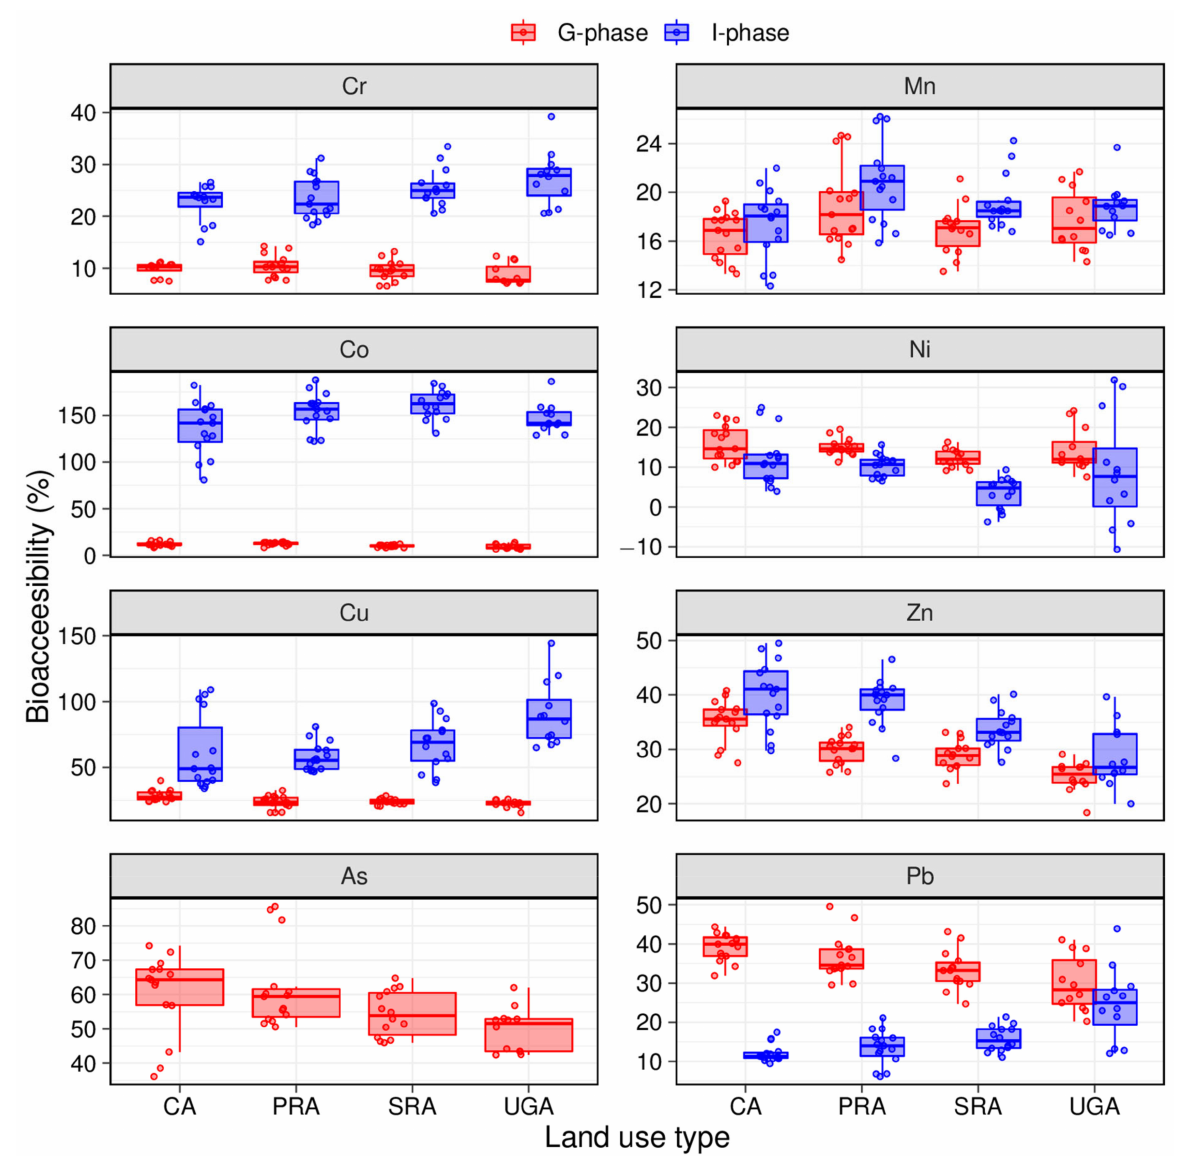
Figure 3. Bioaccessibility of toxic metals in roadside dust in Dhaka city. The circles represent the values of individual sampling points. CA = commercial area, PRA = planned residential area, SRA = spontaneous residential area, UGA = urban green